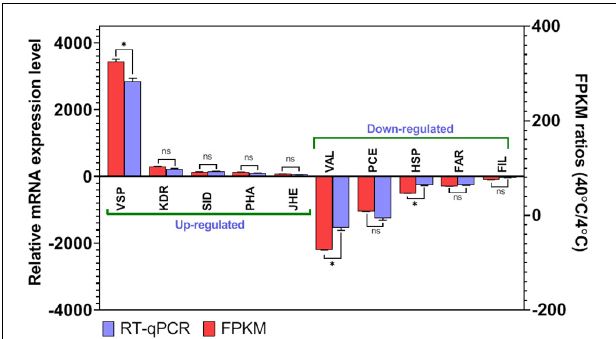
FIGURE 7 | Differentially expressed genes (DEGs) validation by RT-qPCR in comparison to corresponding folding change (FC) data detected in RNA-Seq. Relative genes expression (T40/T4) is shown as the ratio of them per EF1 α . Each treatment includes three technical replicates. Asterisks above standard deviation bars indicate significant difference between groups at Type I error = 0.05 (LSD test). The letter “ns” stands for a non-significant difference between